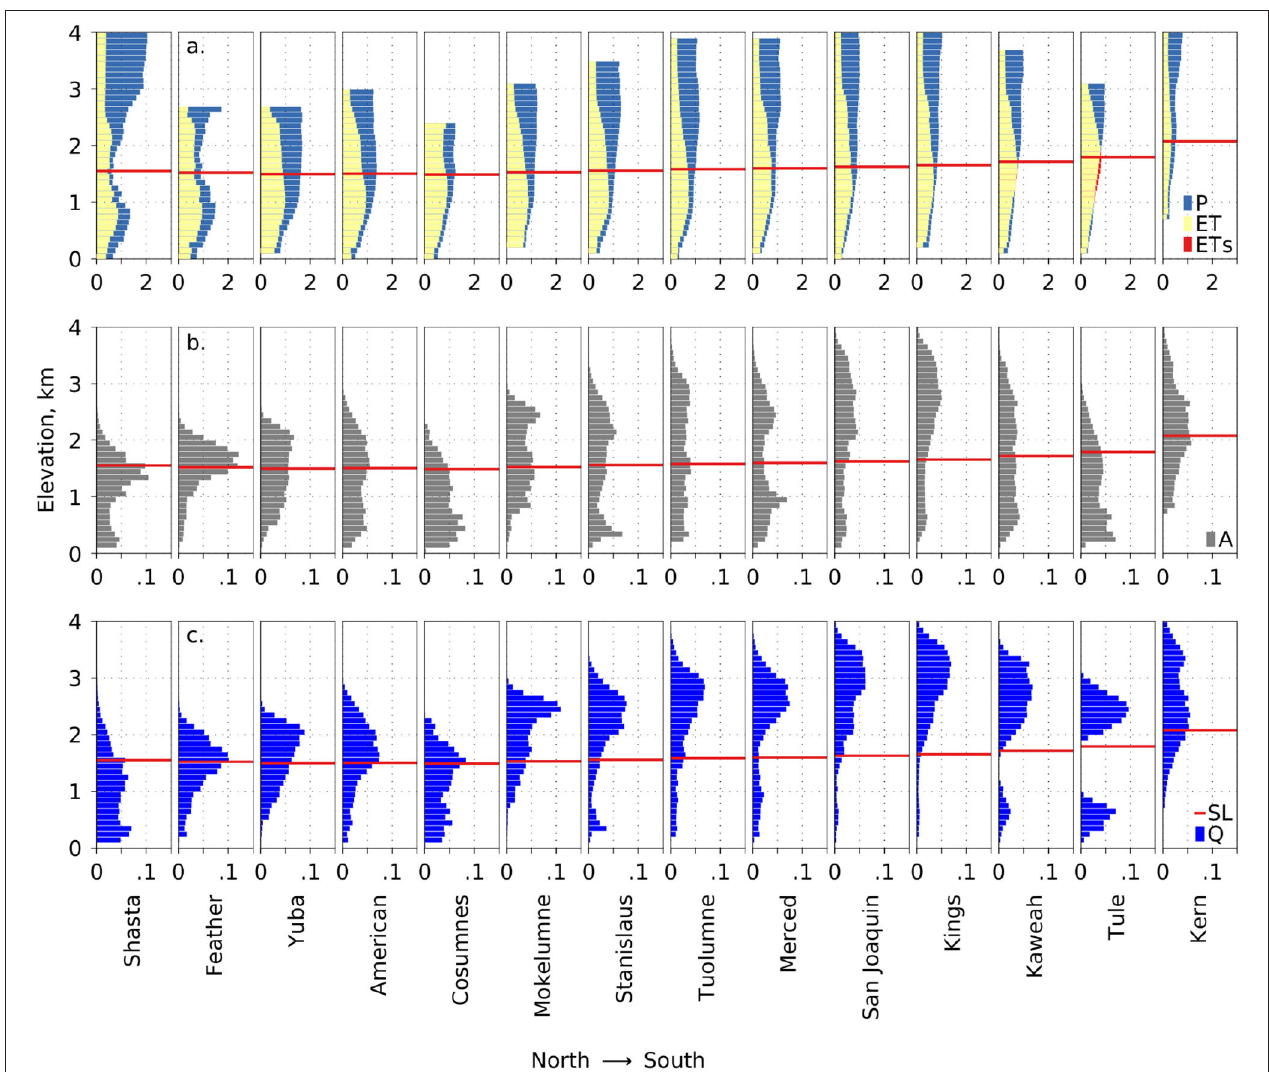
FIGURE 6 | (a) mean-annual precipitation ( P ), evapotranspiration ( ET ) and evapotranspiration from storage ( ET s) by basin and per 100m in elevation; (b) fraction basin area by elevation; (c) fraction of volumetric runoff by elevation. The snowline (SL) indicates the historical rain-snow transition.